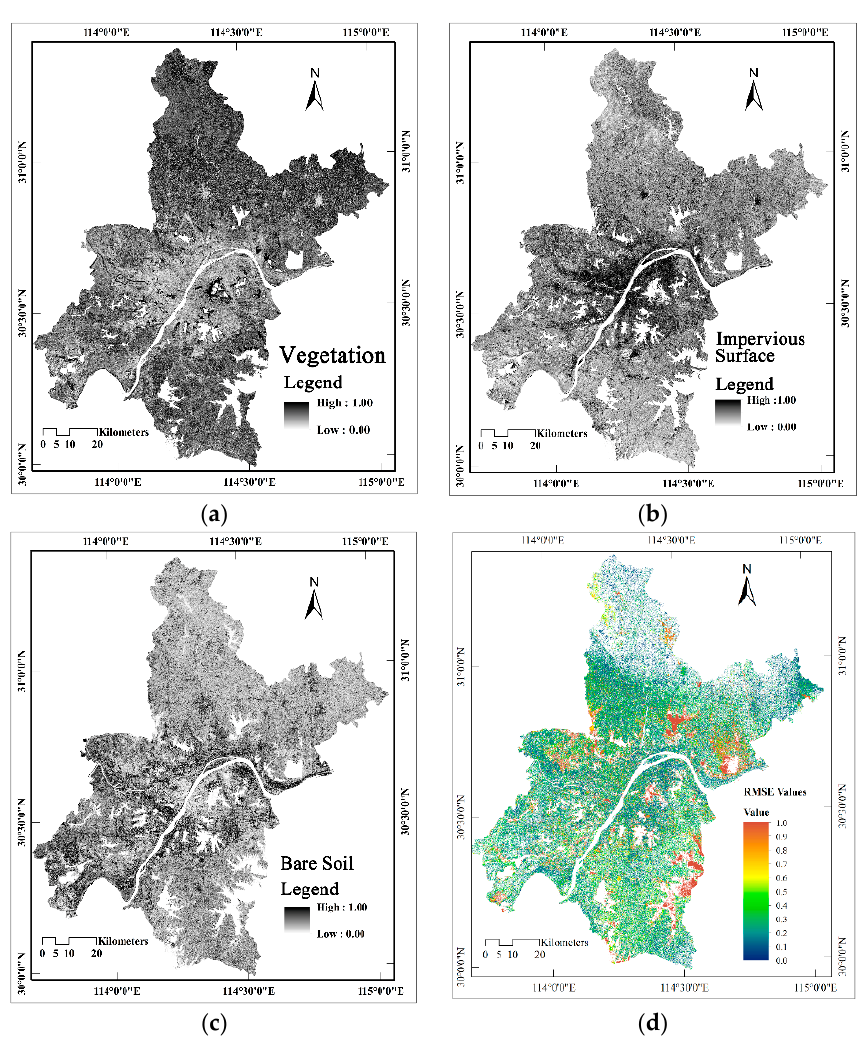
Figure 5. The result of three-endmember spectral mixture analysis (3em-MESMA). ( a ) Fraction of vegetation; ( b ) fraction of impervious surface; ( c ) fraction of soil; ( d ) error image.